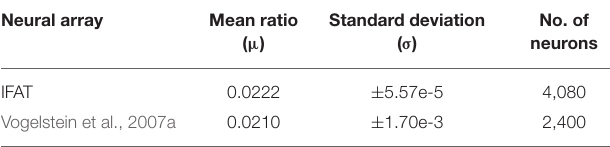
TABLE 2 | Array characterization showing output events per input event. Neural